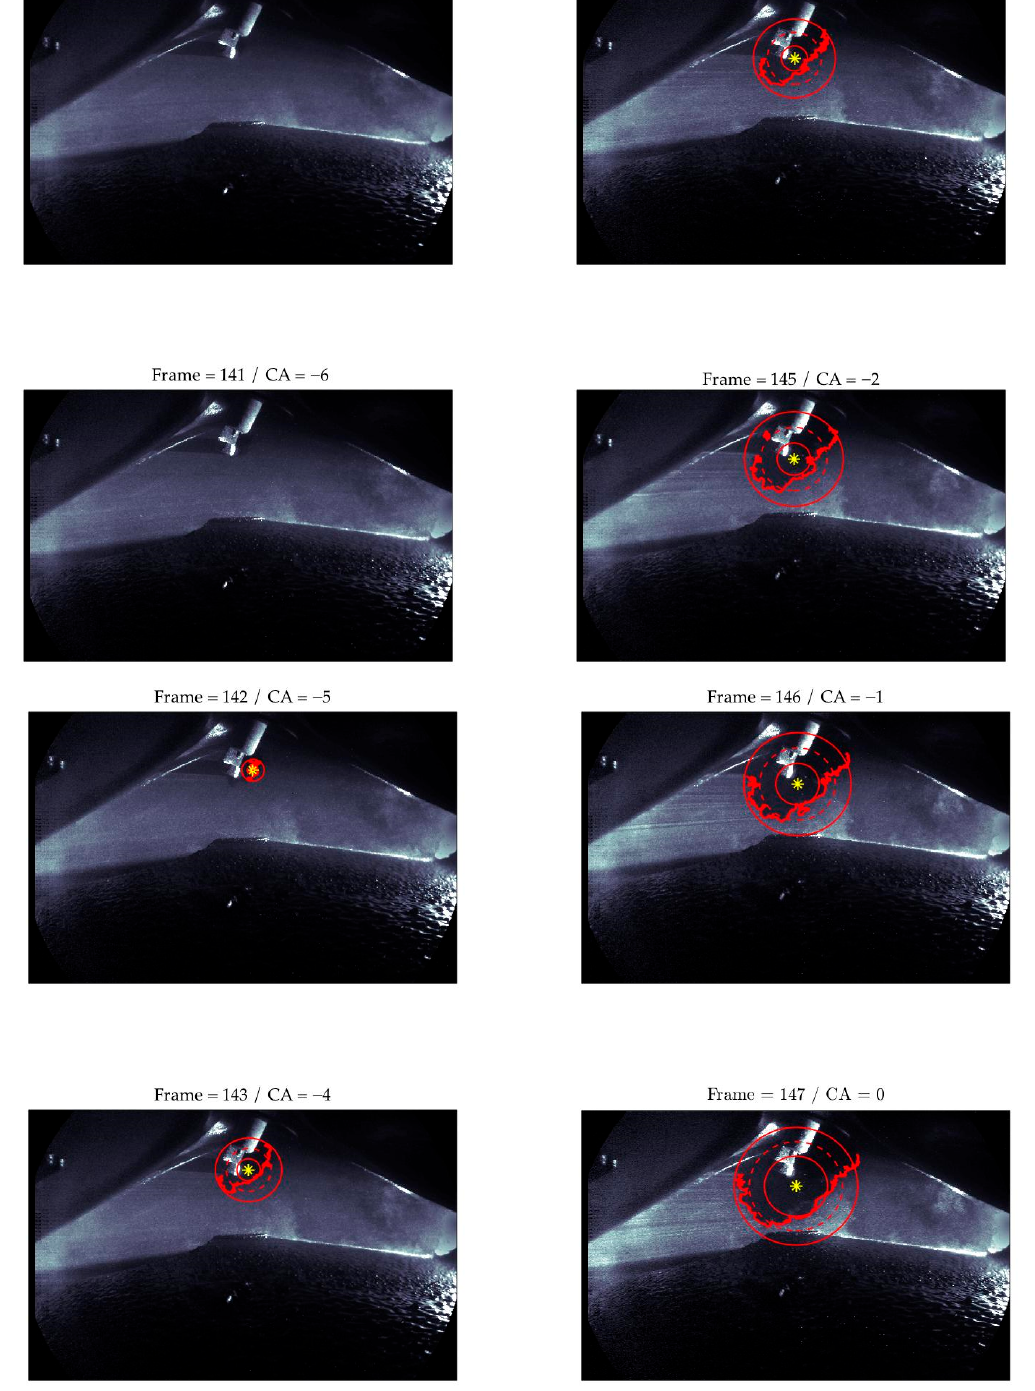
Figure 13. Cycle 59. Background corrected images of turbulent flame from − 7 CAD to TDC firing. Superimposed geometric properties: flame edges, flame center, min, max, and average radii. Engine operation: 1000 RPM, wide open throttle.